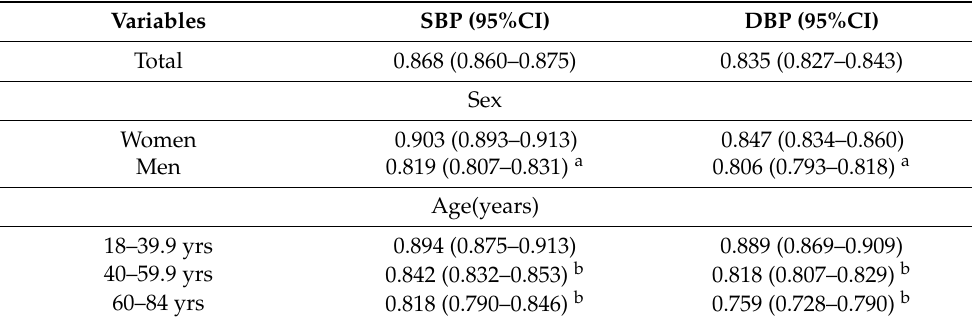
Table 3. AUC values of sex- and age-specific blood pressure for identifying arteriosclerosis.